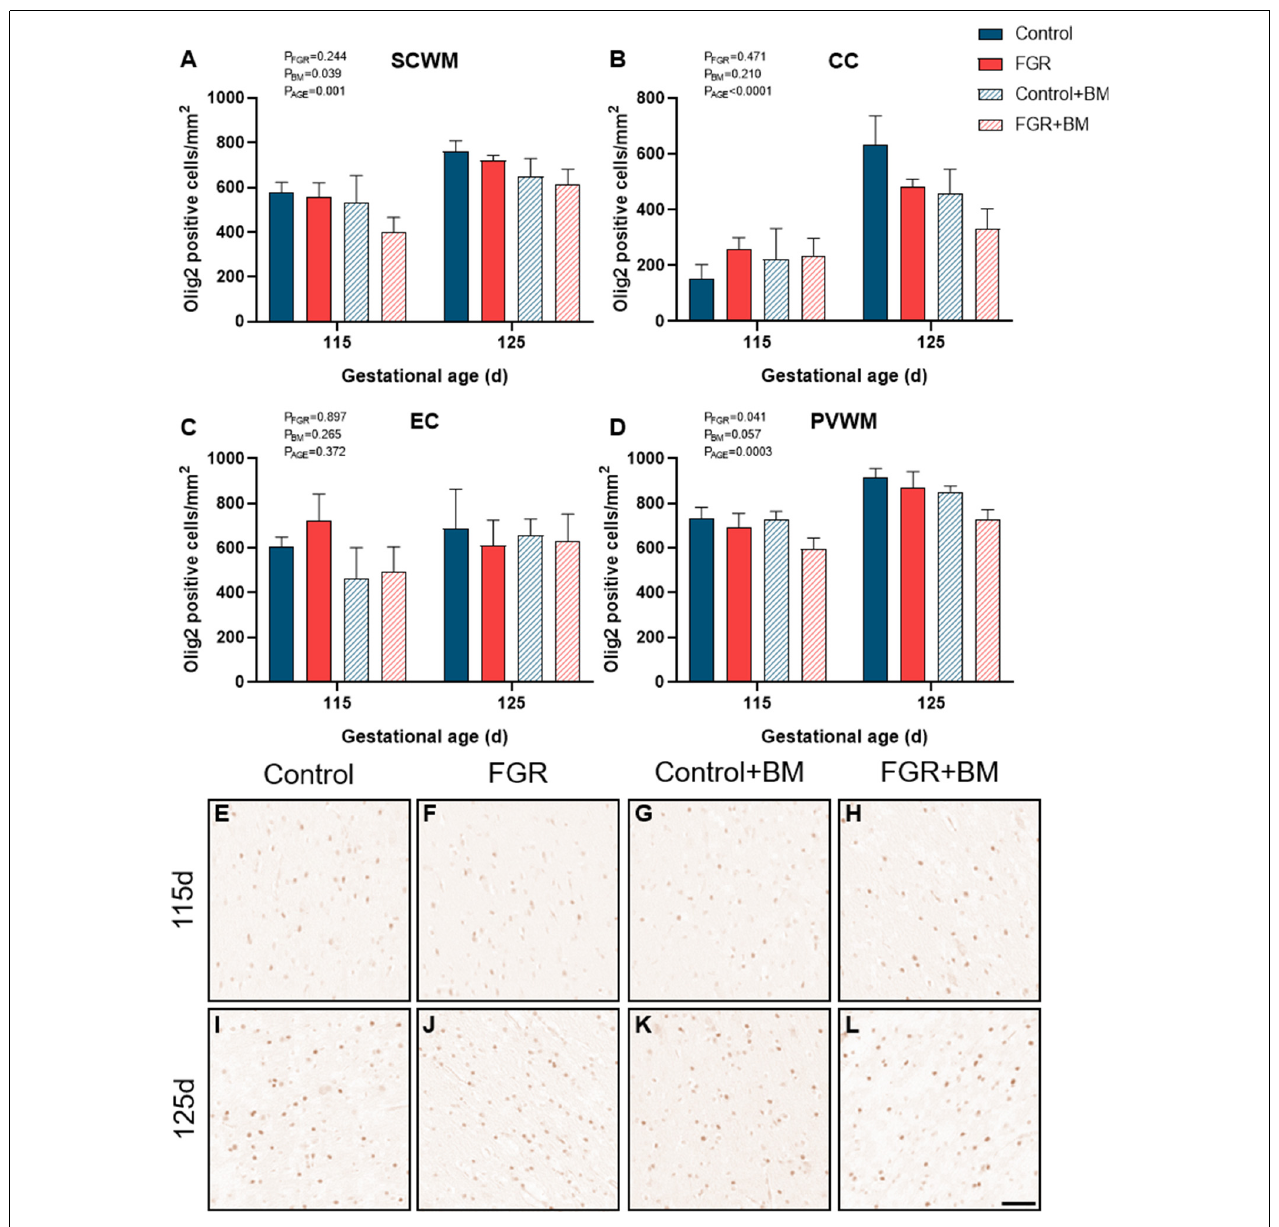
FIGURE 2 | Olig2 immunoreactivity. The number of Olig2 positive cells in the subcortical white matter (SCWM; A ), corpus callosum (CC; B ), external capsule (EC; C ) and periventricular white matter (PVWM; D ) and photomicrographs of the SCWM from 115 days control (E) , fetal growth restriction (FGR; F ), control+BM (G) , FGR+BM (H) and 125 days control (I) , FGR (J) , control+BM (K) and FGR+BM (L) fetuses. Data are presented as mean ± SEM, scale bar = 50 µ